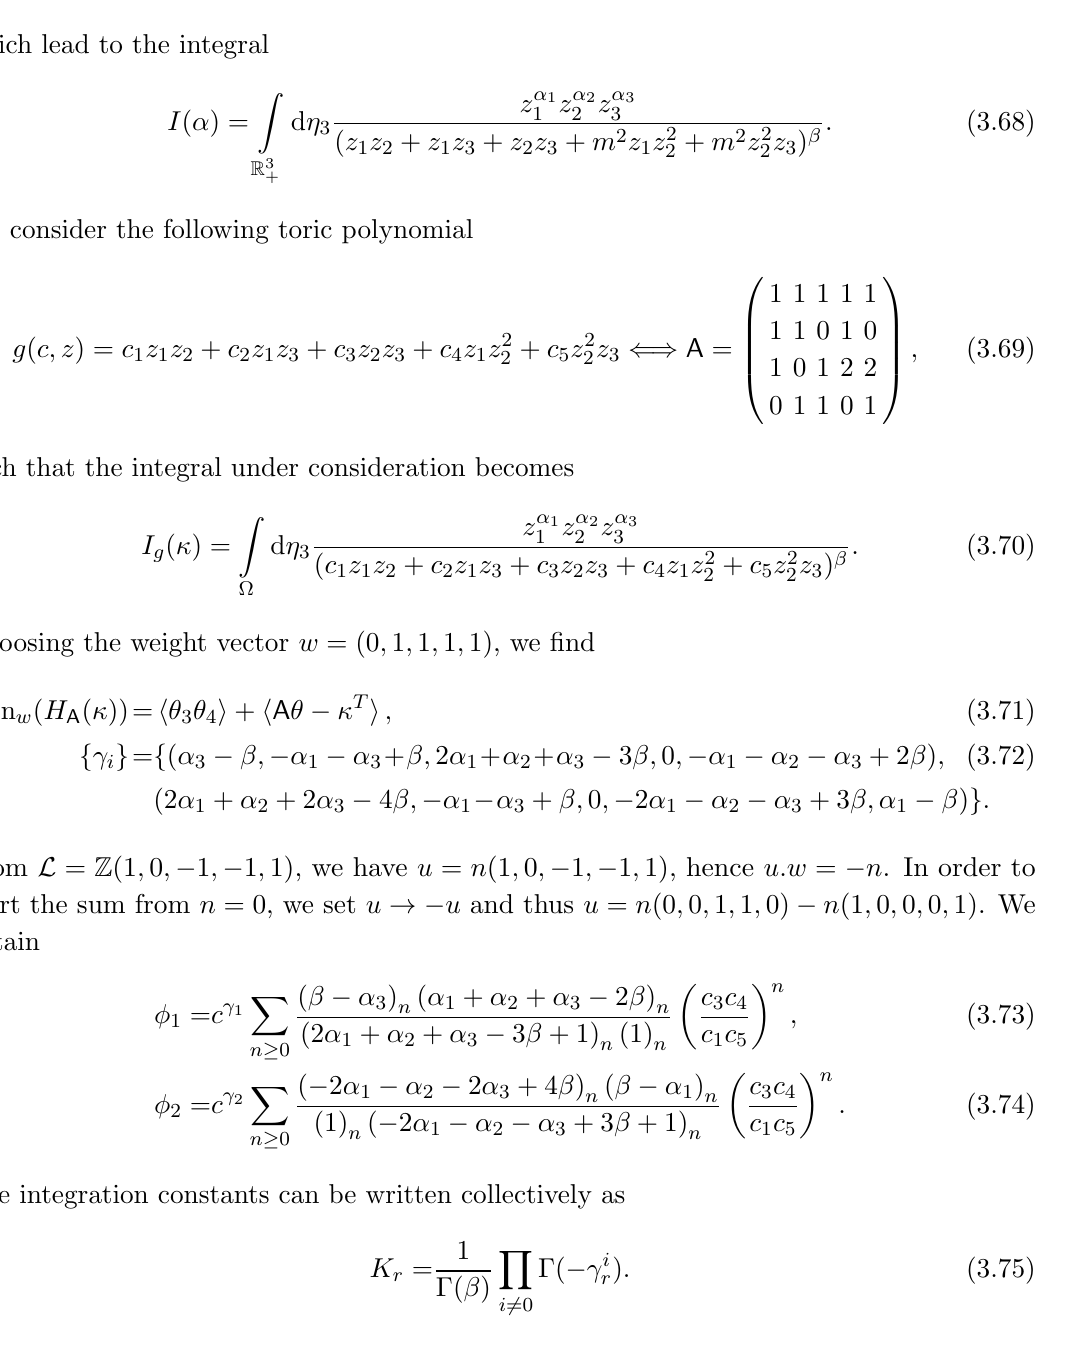
Figure 8 . Sunset